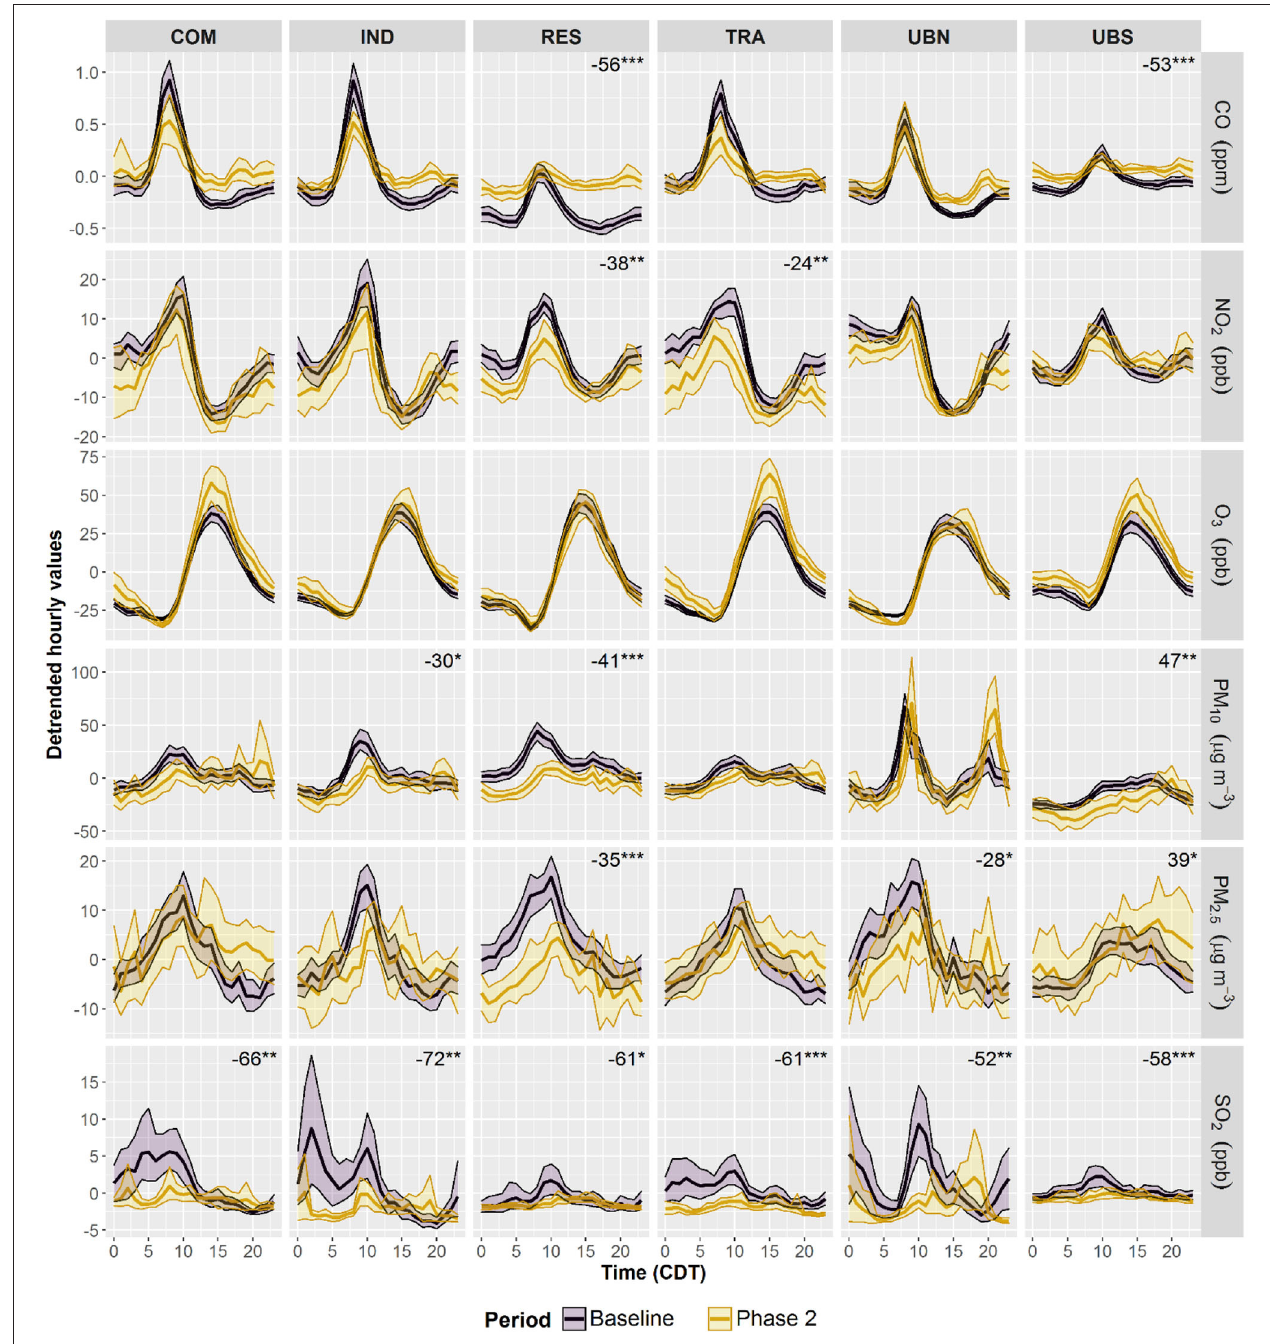
FIGURE 4 | Average diurnal cycles within the MCMA during 2016–2019 and lockdown Phase 2. De-trended diurnal cycles were constructed by subtracting daily averages modelled with Equation (1) from hourly averages to remove the impact of long-term trends. The shading shows the 95% confidence intervals of the average, calculated through bootstrap re-sampling for 1,000 iterations. The numbers show significant changes in diurnal amplitudes, through-to peak, expressed as percentage with 2016–2019 cycles as baseline. *Level of significance p < 0.05. **Level of significance p < 0.01. ***Level of significance p < 0.001.